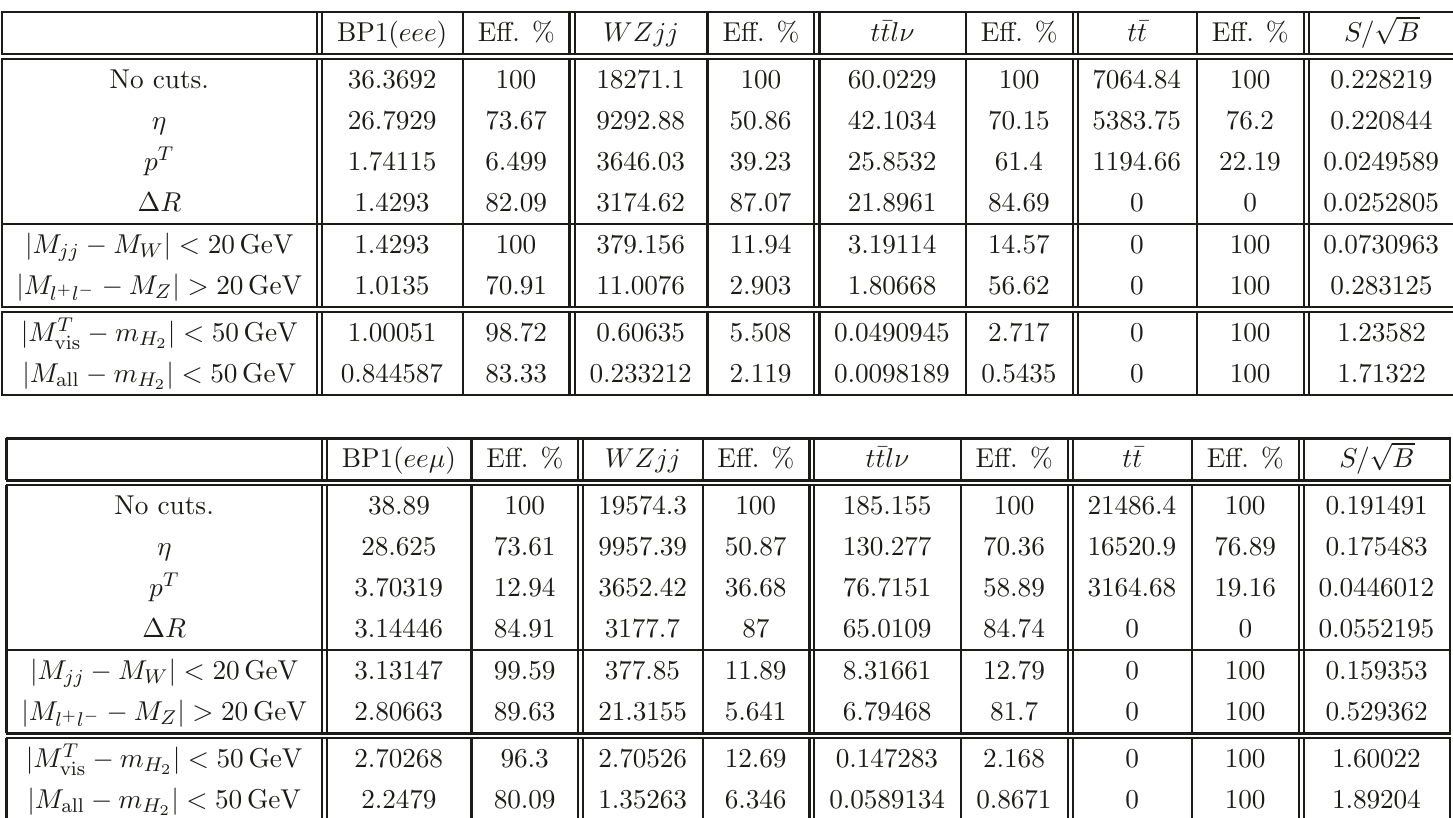
Table 2 . Benchmark point BP1. Luminosity ∆ R lj > 0 . 4 + ∆ R ll > 0 . 3. Transverse momentum cuts for the eee category: p T the eeµ category: p T than 10 − 4